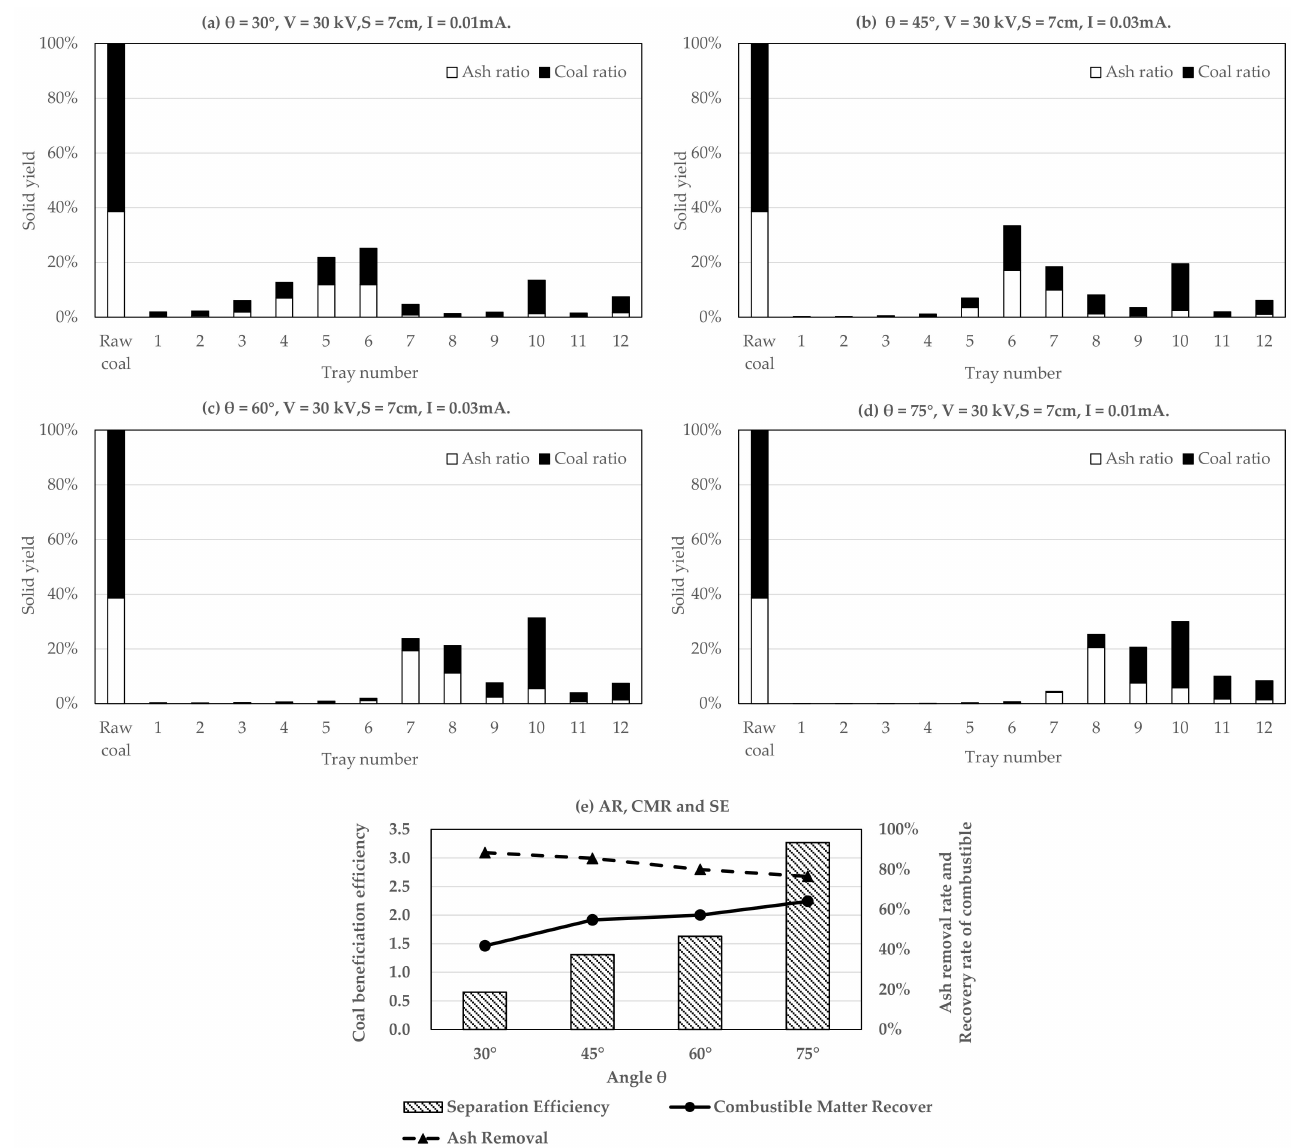
Figure 4. Influence of the angle θ on coal beneficiation effect (three experimental conditions ( a – d )): the voltage V is 30 kV, and the distance S between the electrode and drum is 7 cm; ( e ): the results for AR, CMR and